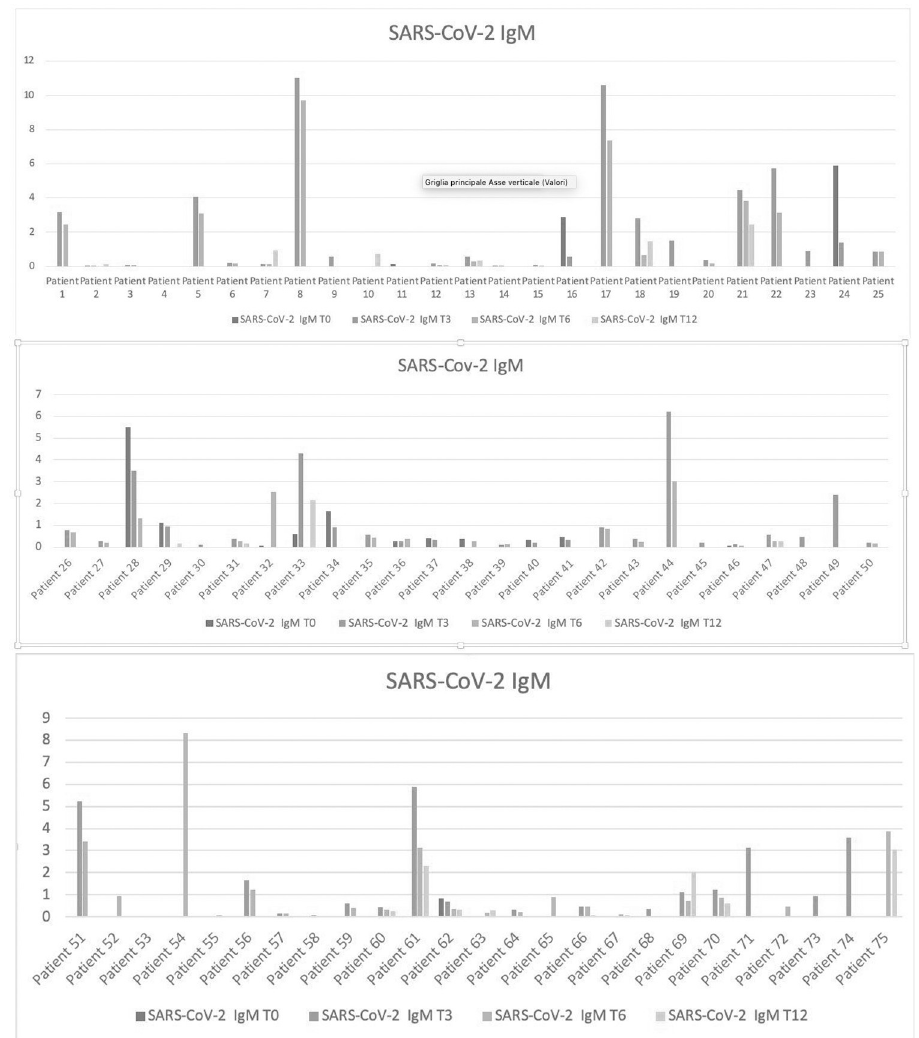
Fig 2. a. Serum IgM Antibodies levels in a subgroup of patients from 1 to 25. Serum IgM Antibodies levels in a subgroup of patients from 1 to 25 at baseline (T0; blue line), month 3 (T3; orange line), month 6 (T6; grey line), month 12 (T12; yellow line). b. Serum IgM Antibodies levels in a subgroup of patients from 26 to 50. Serum IgM Antibodies levels in a subgroup of patients from 26 to 50 at baseline (T0; blue line), month 3 (T3; orange line), month 6 (T6; grey line), month 12 (T12; yellow line). c. Serum IgM Antibodies levels in a subgroup of patients from 51 to 75. Serum IgM Antibodies levels in a subgroup of patients from 51 to 75 at baseline (T0; blue line), month 3 (T3; orange line), month 6 (T6; grey line), month 12 (T12; yellow